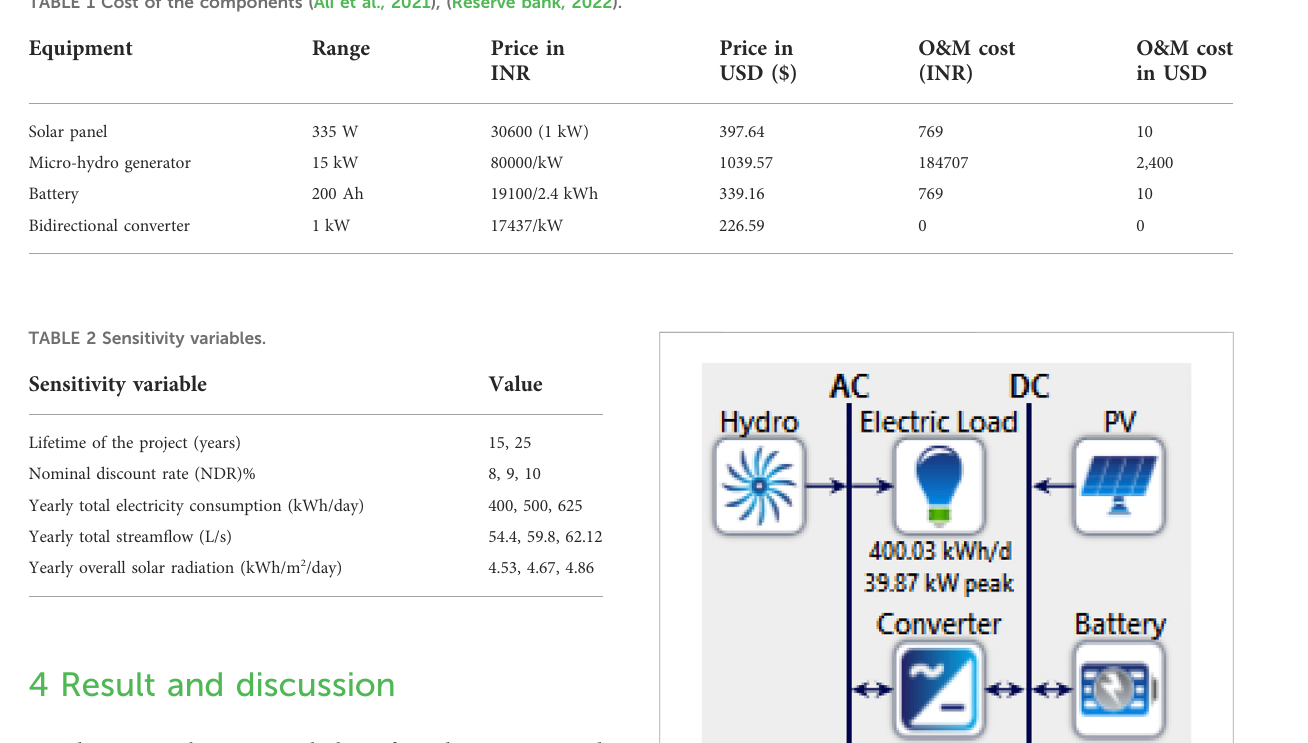
FIGURE 6 Simulation of the hybrid